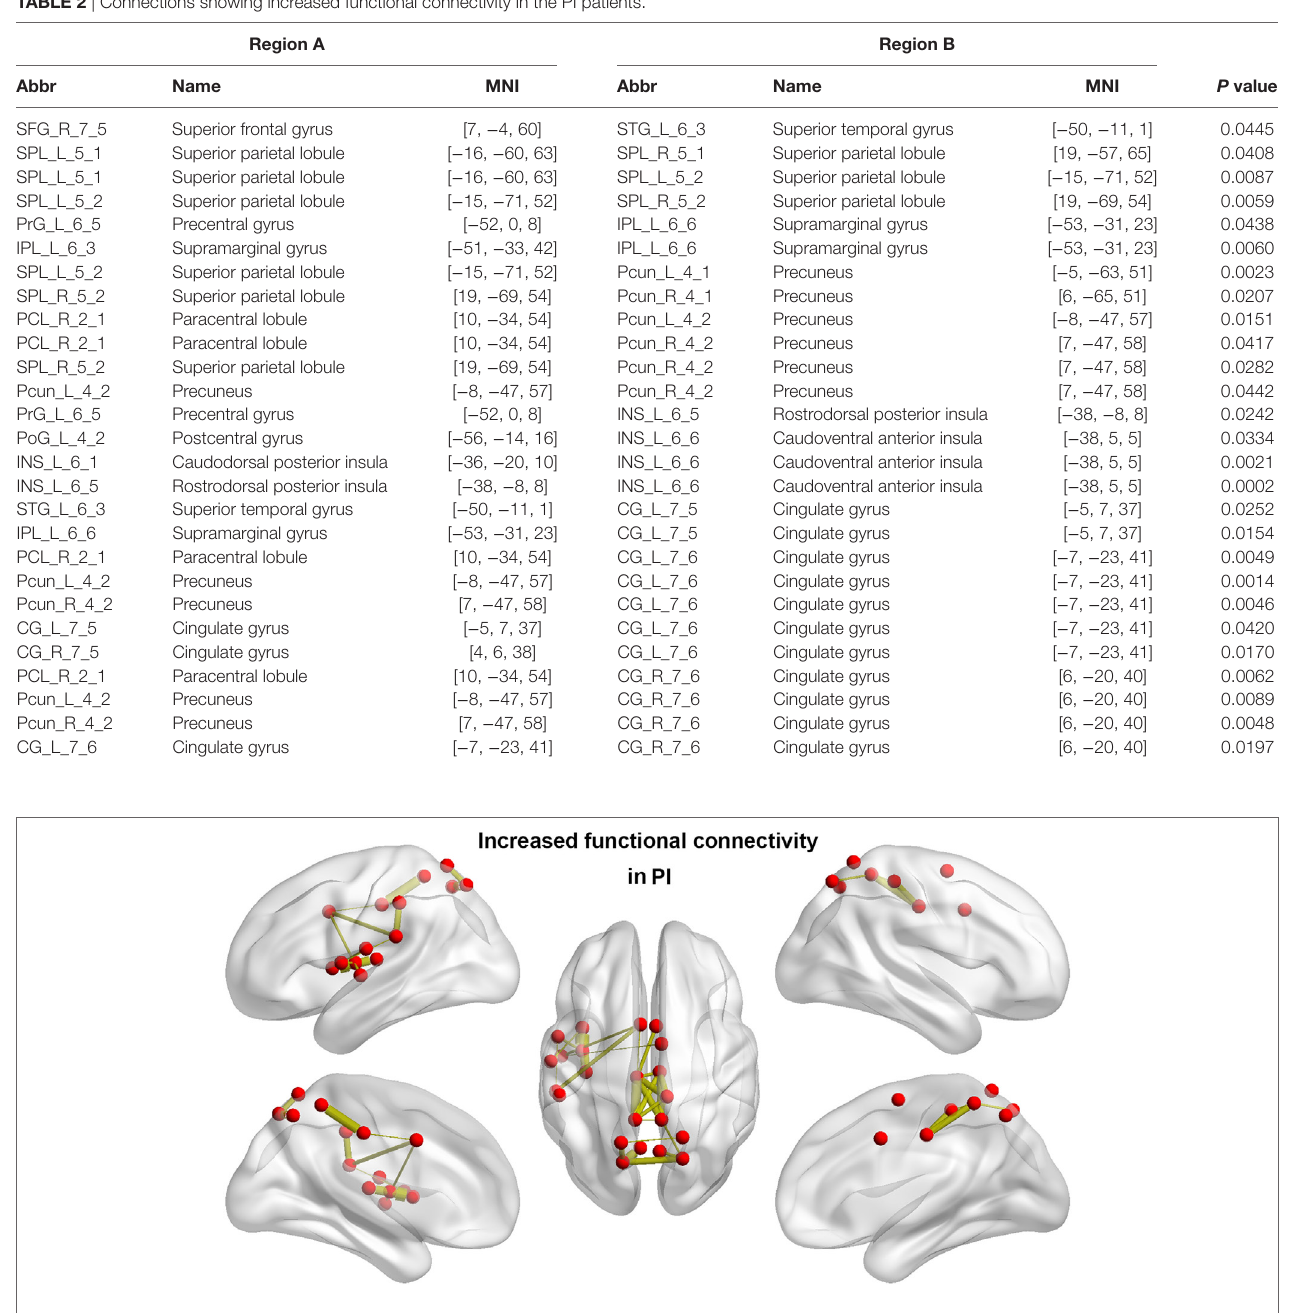
FigUre 3 | Between-group differences in functional connectivity. Patients with PI showed significantly increased functional connectivity that mainly involved the parietal and prefrontal regions and the insula. Line width is proportional to the significance level of the between-group difference. PI, primary insomnia.